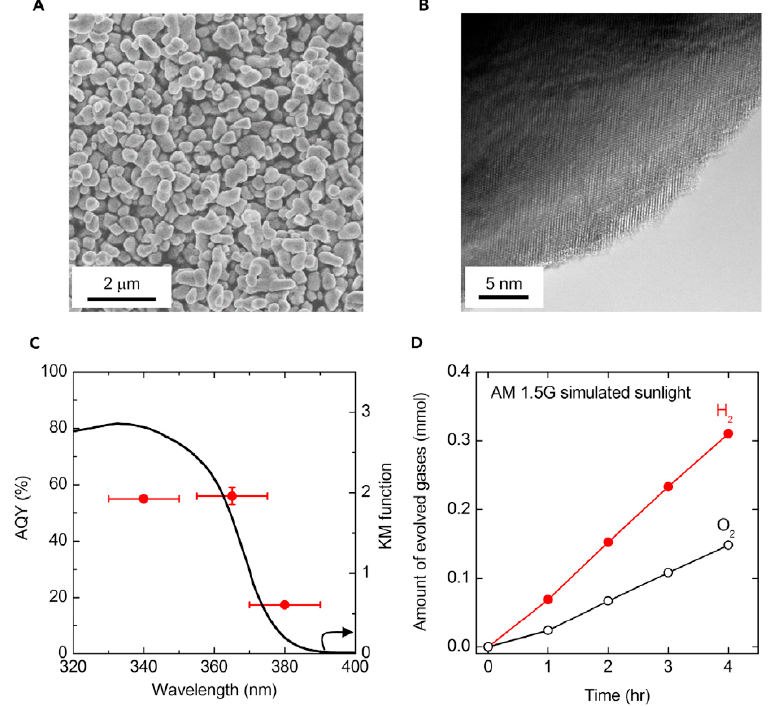
Figure 5. Microscopic views and photocatalytic water ‐ splitting reactitvity of Al ‐ doped SrTiO 3 single ‐ powder photocatalyst, loaded with RhCrO x cocatalyst. ( A ) scanning electron microscopic image of Al:SrTiO 3 powder. ( B ) high ‐ resolution transmission microscopic image of a RhCrO x /Al:SrTiO 3 grain. ( C ) apparent quantum yield (AQY, red plots) for overall water photo ‐ splitting in pure water as a function of the incident wavelength. The light was delivered by a Xe lamp and the wavelength was controlled by corresponding bandpass filters with the window widths indicated by the error bars. The evolved H 2 and O 2 were quantified by gas chromatography. The coinciding diffuse absorption spectrum of this catalyst is also indicated (black curve as Kubelka ‐ Munk function). The active wavelength range is in the ultraviolet region. ( D ) The time course of overall water photo ‐ splitting by RhCrO x /Al:SrTiO 3 under simulated sunlight (AM 1.5 G). Reaction conditions: catalyst weight 100 mg in 100 mL of pure H 2 O, at 288 K and 10 kPa. Stoichiometric decomposition of water is demonstrated for 4 hours. (Reproduced from [38]).